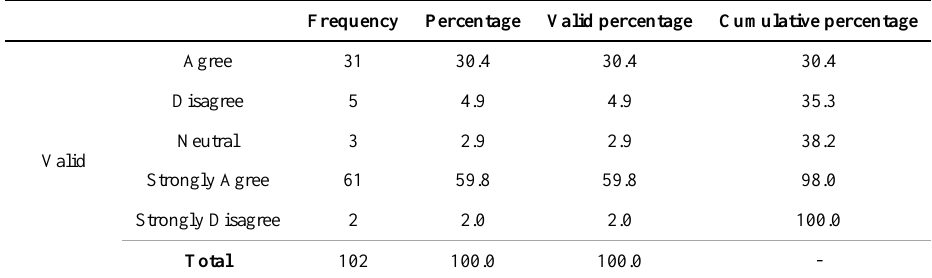
Table 8. Implementation of control in the public sector is enhanced by the use of smart tools and